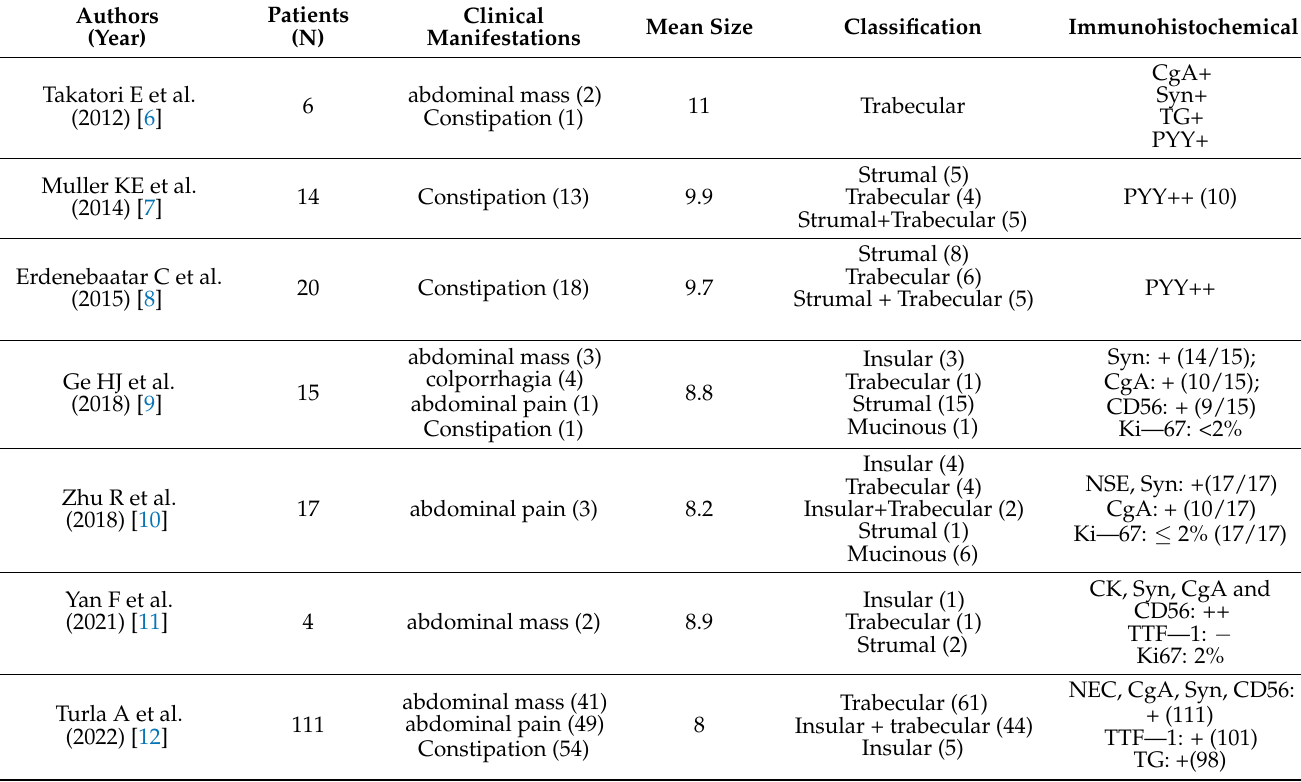
Table 1. Classification and clinical manifestation of ovarian strumal carcinoid.